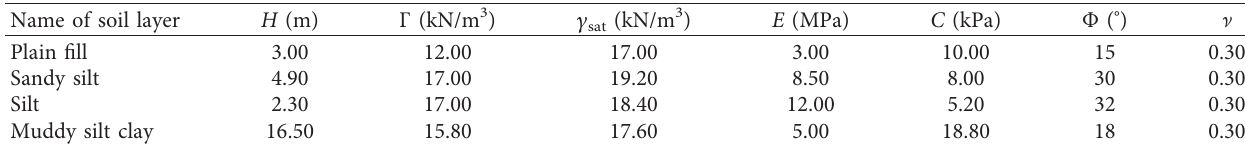
Table 3: Physical and mechanical parameters of soil